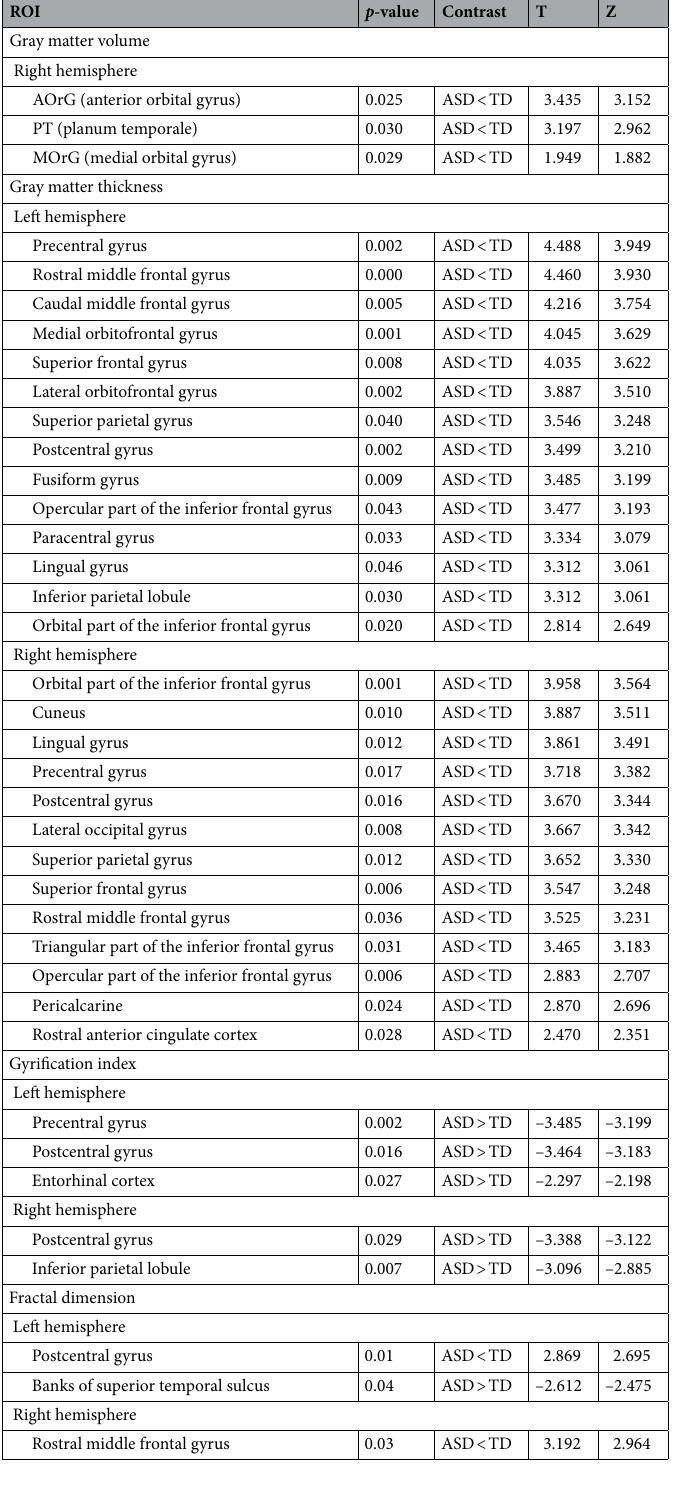
Table 2. The results of the whole-brain analysis in volume- and surface-based parameters (ASD vs. TD groups of children). All p -values are Holm-Bonferroni corrected (<